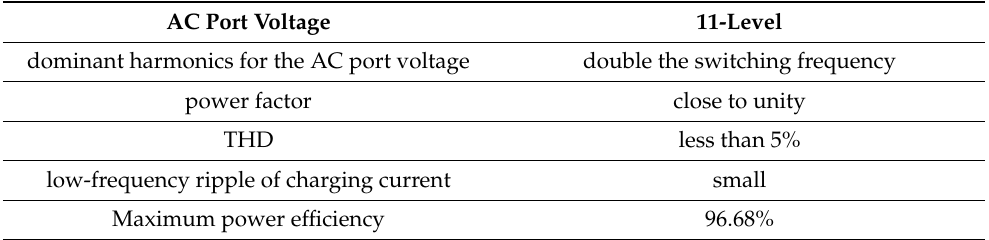
Table 2. Merits of the proposed CADPCI of